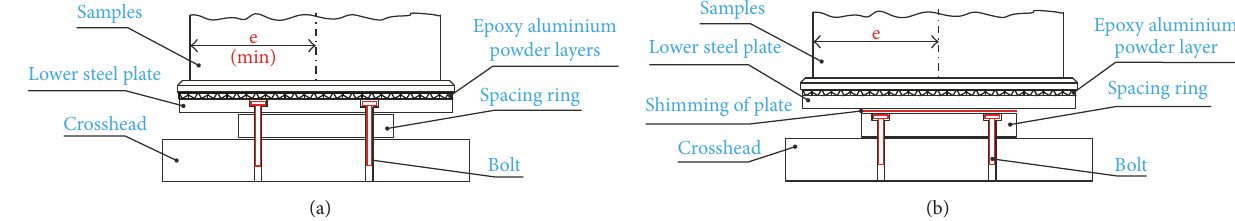
Figure 6: Schematic of the lower shell support for most of the specimens (a) and for shells R29 and R30 (b).